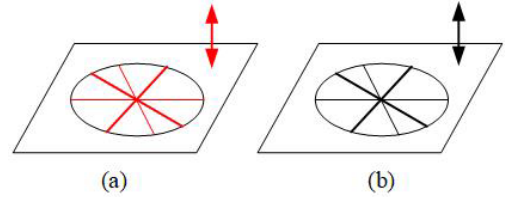
Figure 6. Freedom and constraint spaces of the 2R1T motion branch. (a) Freedom space. (b) Constraint